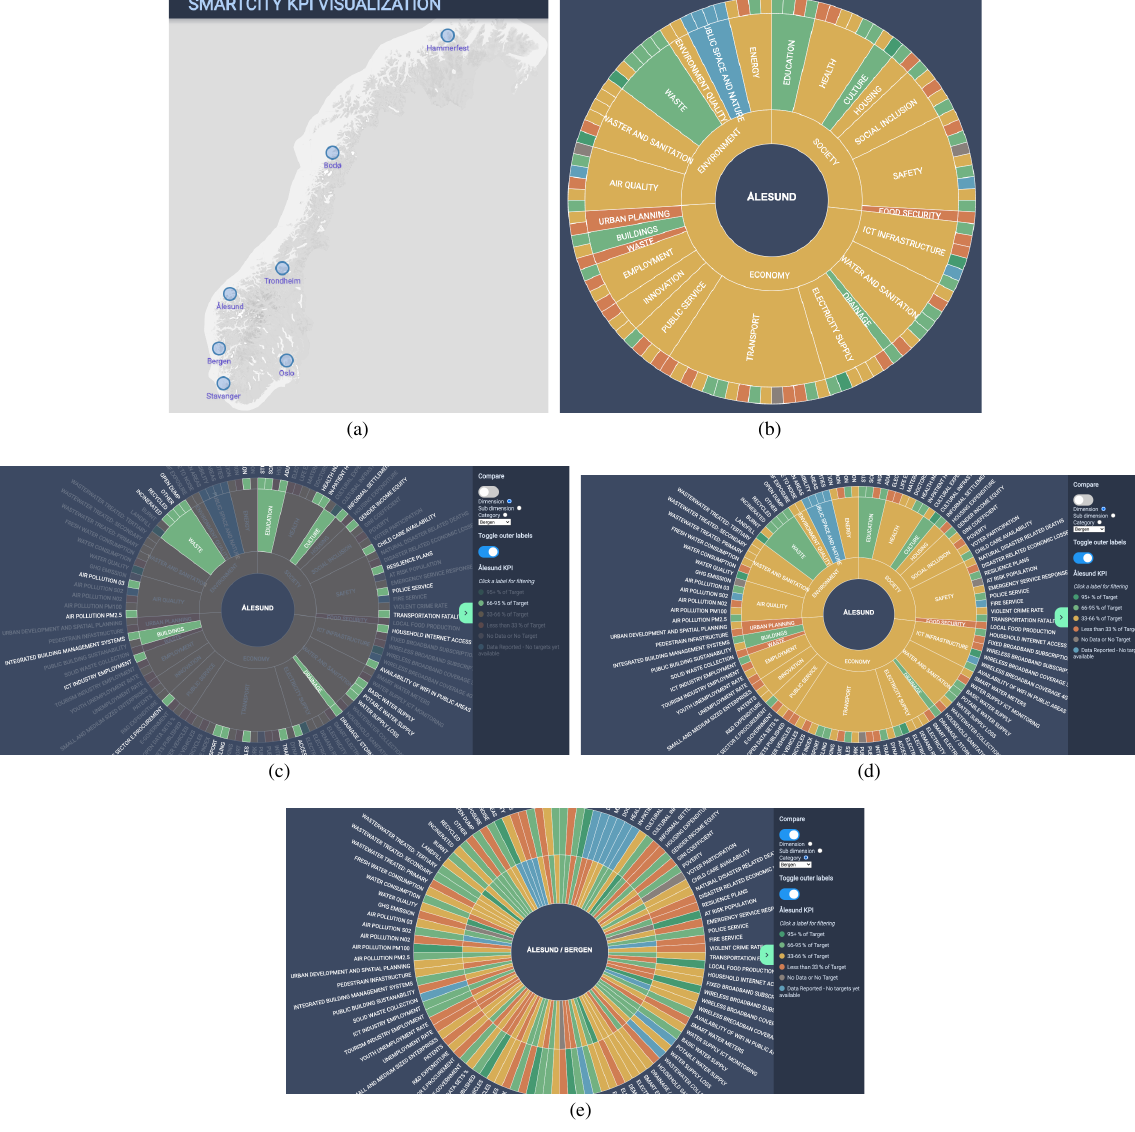
Figure 3. Overview of features of the developed tool. (a) Map-based municipality selection. (b) Example of a KPI chart. (c) Visualization of SGD labels. (d) Selection of SGDs based on performance. (e) Comparison of KPIs of two